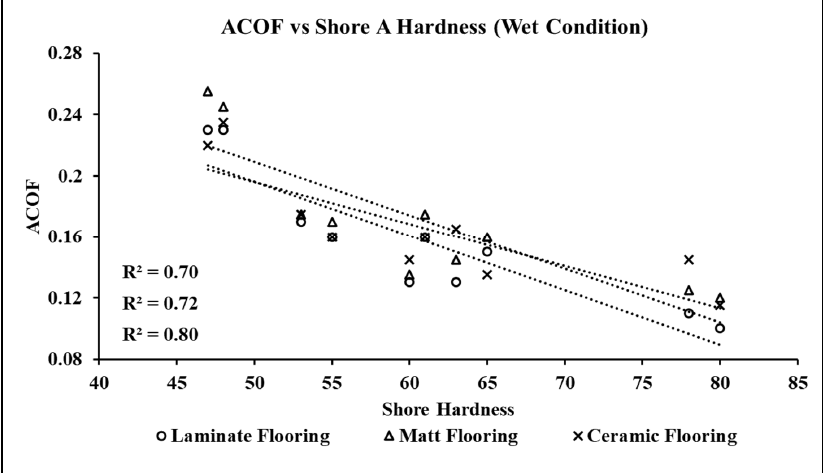
Figure 11. Correlation between shore hardness and ACOF across the shoes in wet slipping condition.